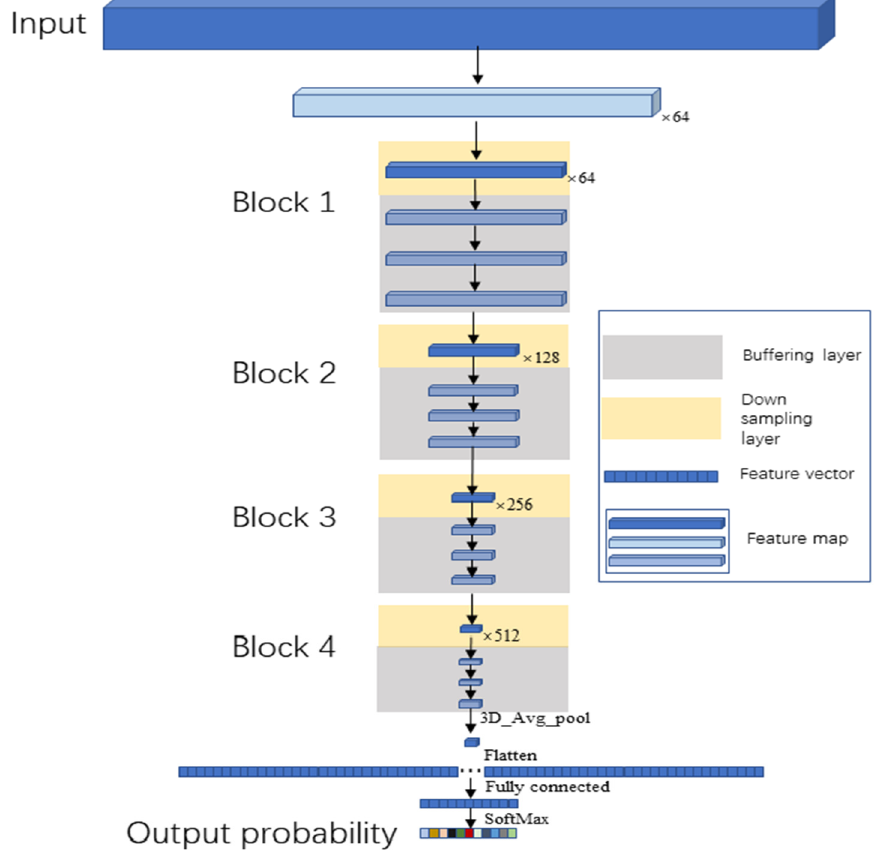
Figure 3. The architecture of the Buffer Net and the data flow. The input was HMI images at a size of 200 × 25 × 25. Firstly, it was down sampled with the output as 64 feature maps, whose sizes were 98 × 25 × 25. Then, they were input to the four blocks to down sample and buffer. The size of the output feature maps for the four blocks were 49 × 13 × 13, 25 × 7 × 7, 13 × 4 × 4 and 7 × 2 × 2, respectively, and the number of output feature maps for the four blocks were 64,128, 256 and 512, respectively. The feature map output by the fourth block was flattened into a vector after a 3D average pooling, which was then input to the fully connected layer. The final output was the probability for each bacterial genus by SoftMax. For accelerating the training process, every 3D convolutional layer was followed by a 3D Batch Normalization layer.